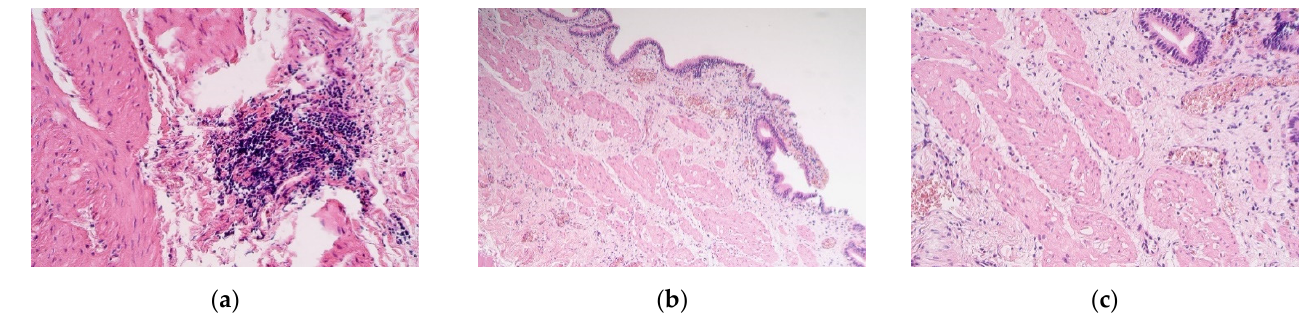
Figure 1. ( a – c ) Micrographs of gallbladder structures in children with cholecystitis. ( a ) Aggregation of lymphocytes in the muscle layer of the gallbladder. Haematoxylin and eosin, ×250; ( b ) the subepithelium infiltrated by the inflammatory cells of the gallbladder. Haematoxylin and eosin, ×100; ( c ) note the vacuolization of the smooth muscle cells. Haematoxylin and eosin, ×200. Table 1. Number of interleukin positive cells in the gallbladder epithelium and connective tissue of patient samples. IL’s/ IL-1 Patients